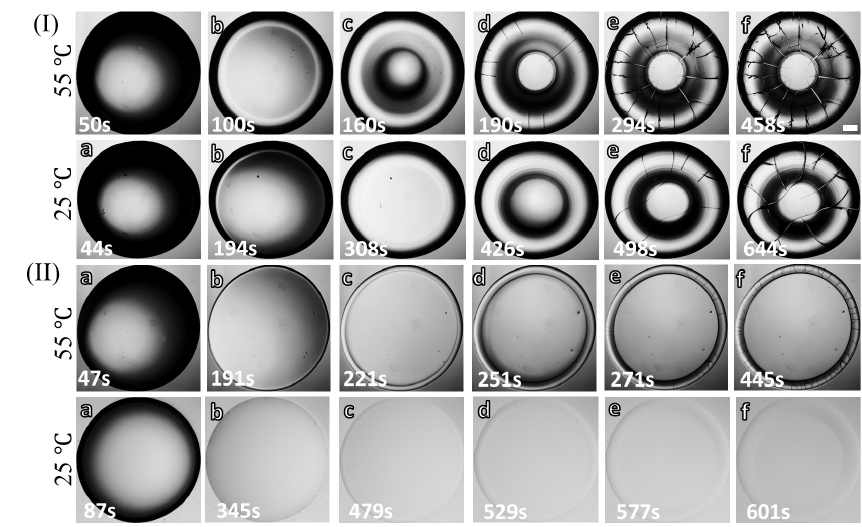
Figure 4. Time evolution of BSA droplets at different substrate temperature (T) during the drying process: (a–f) display different stages at the initial concentration ( φ p ) of ( I ) 20 wt% for T of 55 and 25 ◦ C, and ( II ) 1 wt% at T of 55 and 25 ◦ C. The scale bar (0.2 mm length) is shown with the white rectangle in the top-right panel.